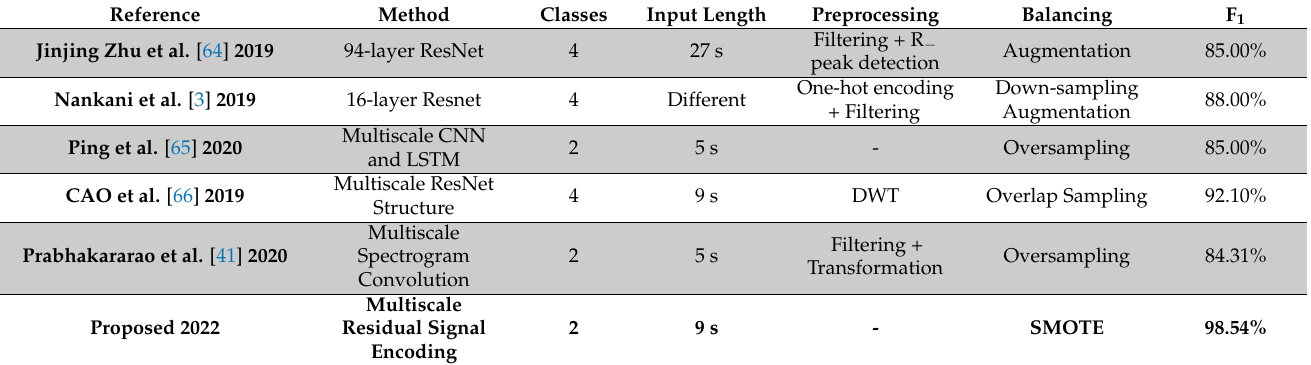
Table 13. Comparison of the results of our proposed model with those of existing state-of-the-art methods.